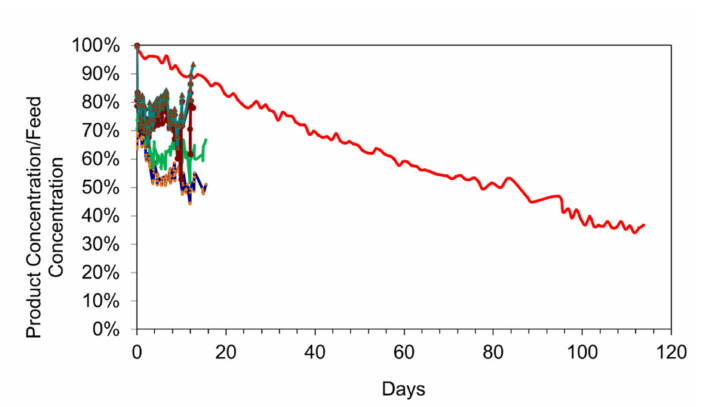
Figure 17. Comparison of different materials for the desalination pellet construction: Salin- ity = 7.52 g L − 1 ; Temperature = 0.2 to 14 ◦ C; water volume = 1 L. Red = Desalination pellet, m-Fe 0 : n-Fe-polymer@n-C 0 , 18 g L − 1 ; Salinity = 7.52 g L − 1 ; Other colours: desalination pellet: